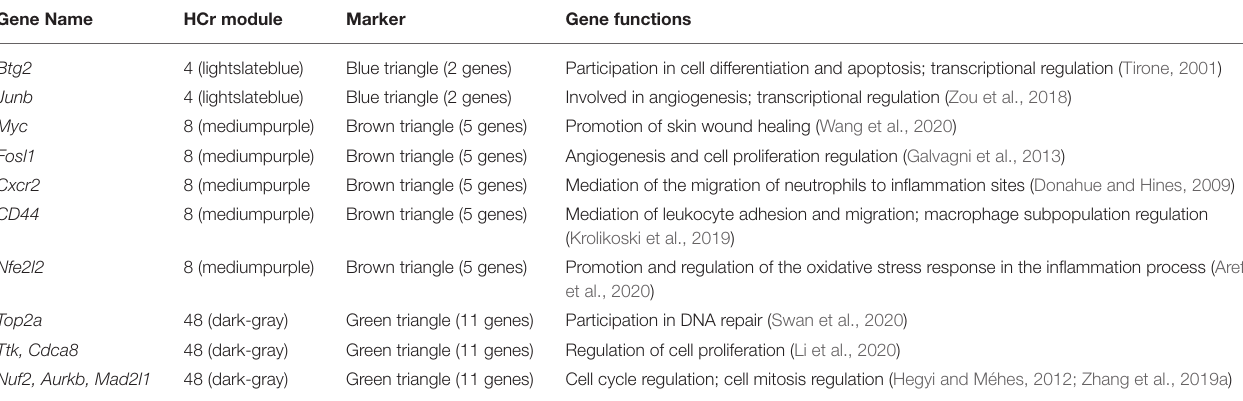
TABLE 2 | Detailed information and main functions of 18 marker